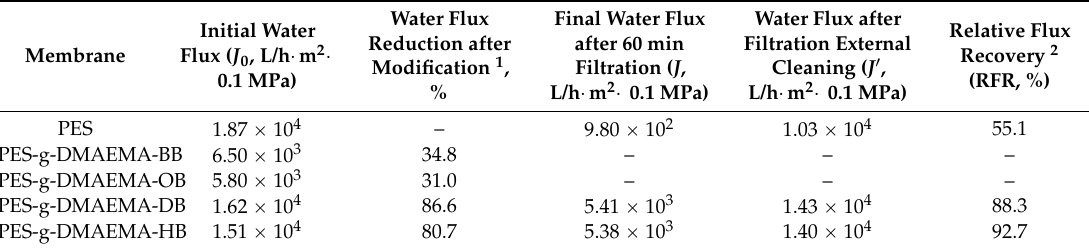
Table 3. Water flux variation of different membranes.